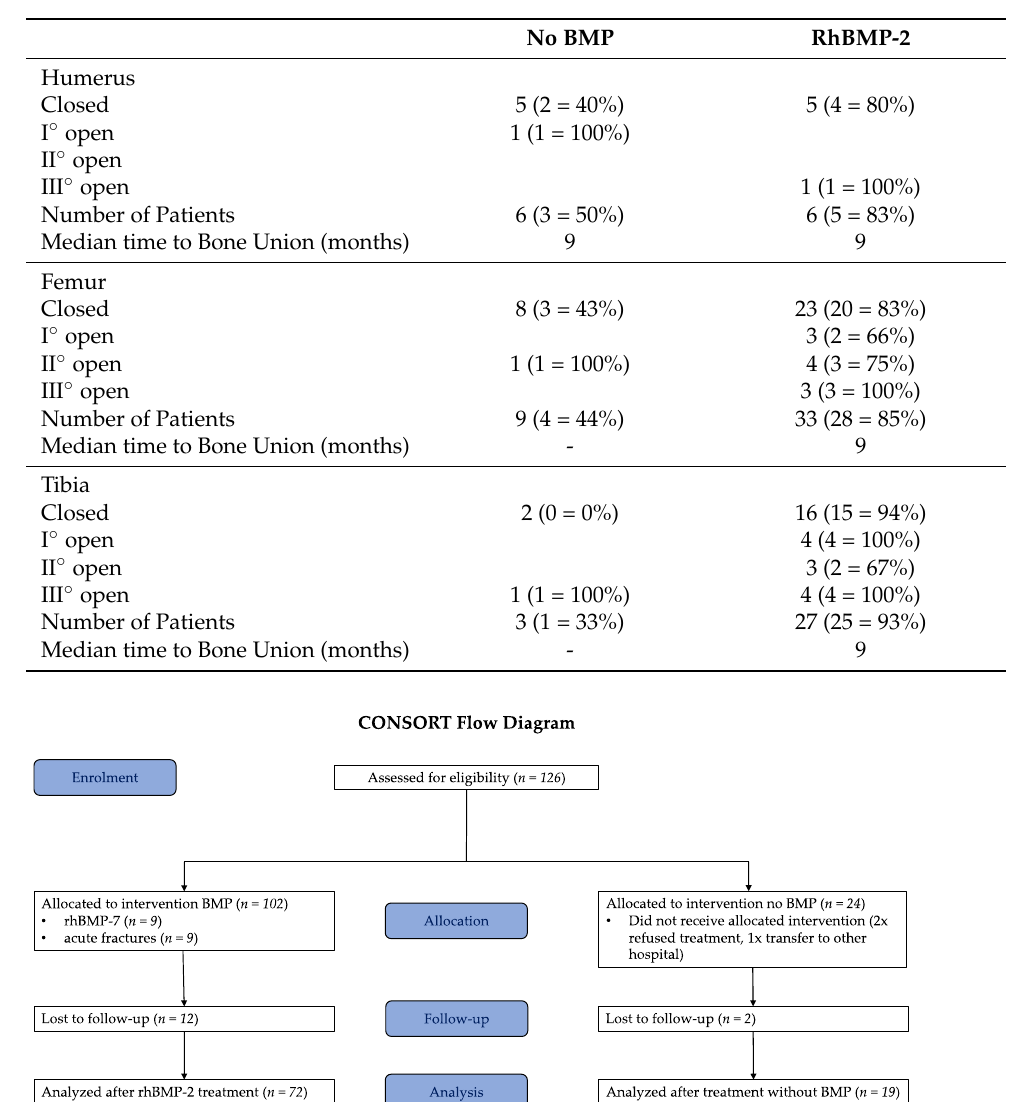
Figure 1. Consort flow diagram indicating enrolment, intervention allocation, and fol- low up. Table 1. Total number of non-unions (bone unions, union rate in %), and time to union for hu- merus, femur, and tibia, as well as degree of open fracture characterizing the study groups.